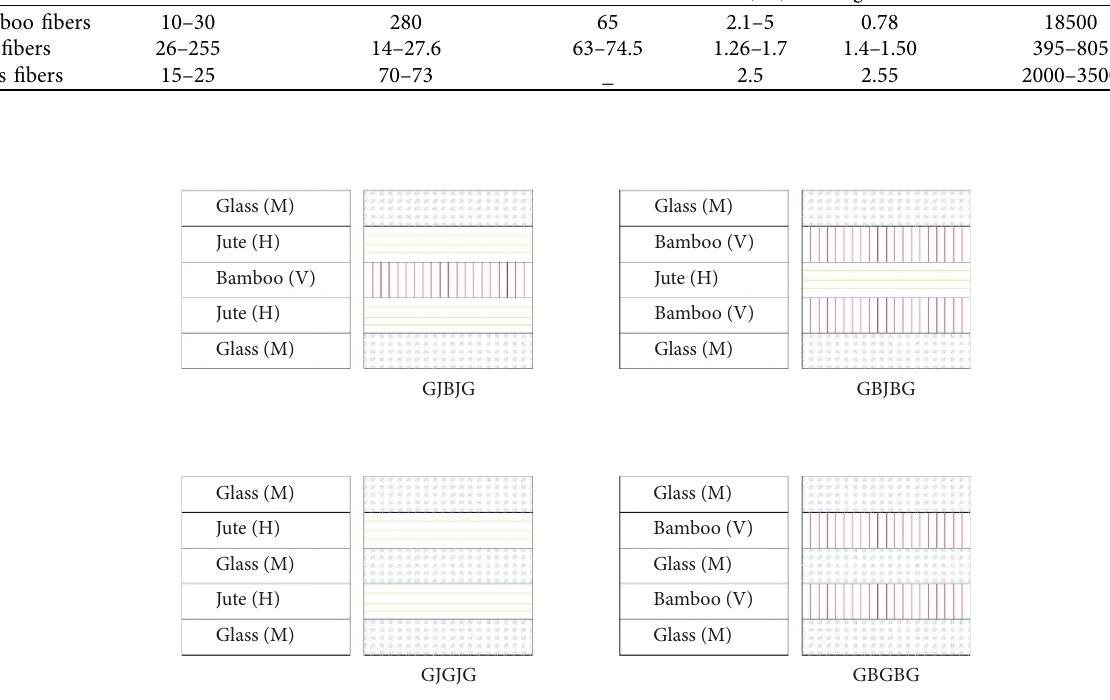
Figure 2: Depiction of the stacking sequence. Table 2: Hybrid sample fiber-matrix